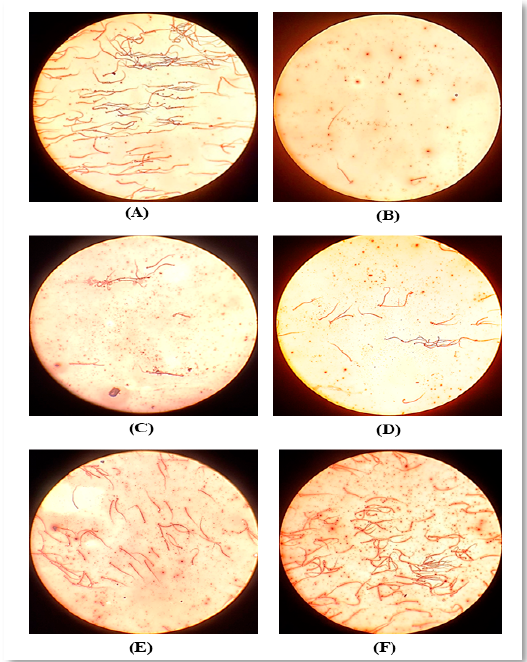
Figure 9. Semen investigation under a light microscope for ( A ): NC, ( B ): CP, ( C ): FO, ( D ): TT; ( E ): SP; ( F ): NCF.